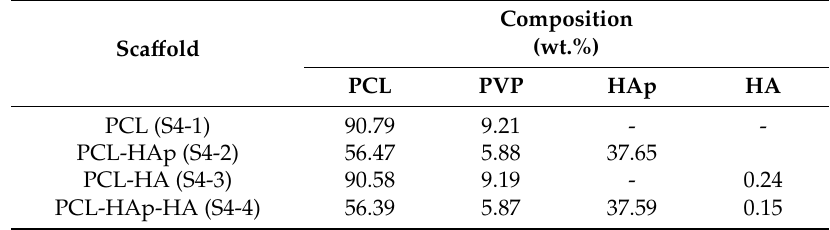
Table 1. Theoretical composition of prepared sca ff olds.